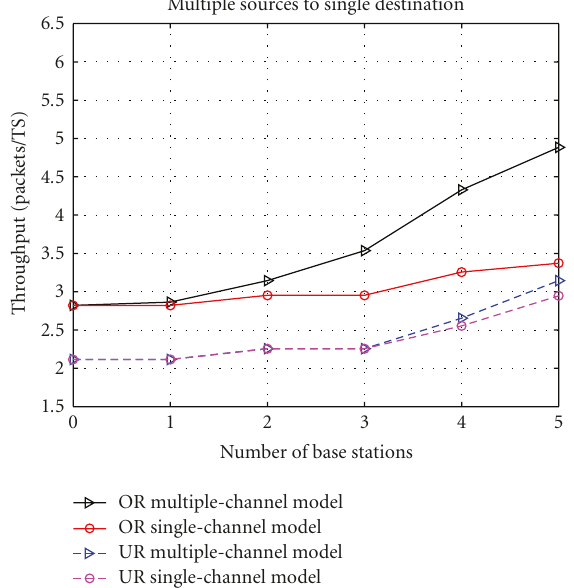
Figure 4: Throughput bound on Random distribution of BTs with two di ff erent models.